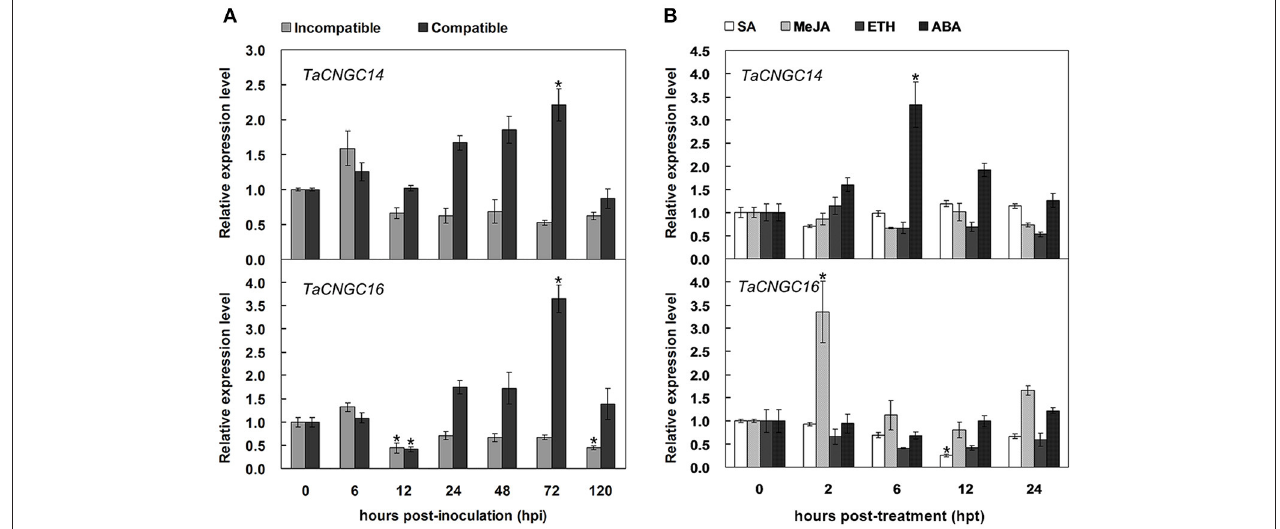
FIGURE 5 | Transcriptional profiles of TaCNGC14 and TaCNGC16 in wheat leaves during interaction of wheat with Pst and exogenous hormone application. (A) Leaf samples inoculated Pst isolates CYR23 (incompatible interaction) and CYR31 (compatible interaction) were collected at 0, 6, 12, 24, 48, and 120 hpi. (B) Four exogenous hormone treatments (SA, MeJA, ETH, and ABA) were sampled with seeding wheat leaves at 0, 2, 6, 12, and 24 hpi. Three biological replicates were calculated by the comparative threshold (2 − 11 CT ) method. Asterisks represent significant differences at the same time point using Tukey’s HSD test ( P <